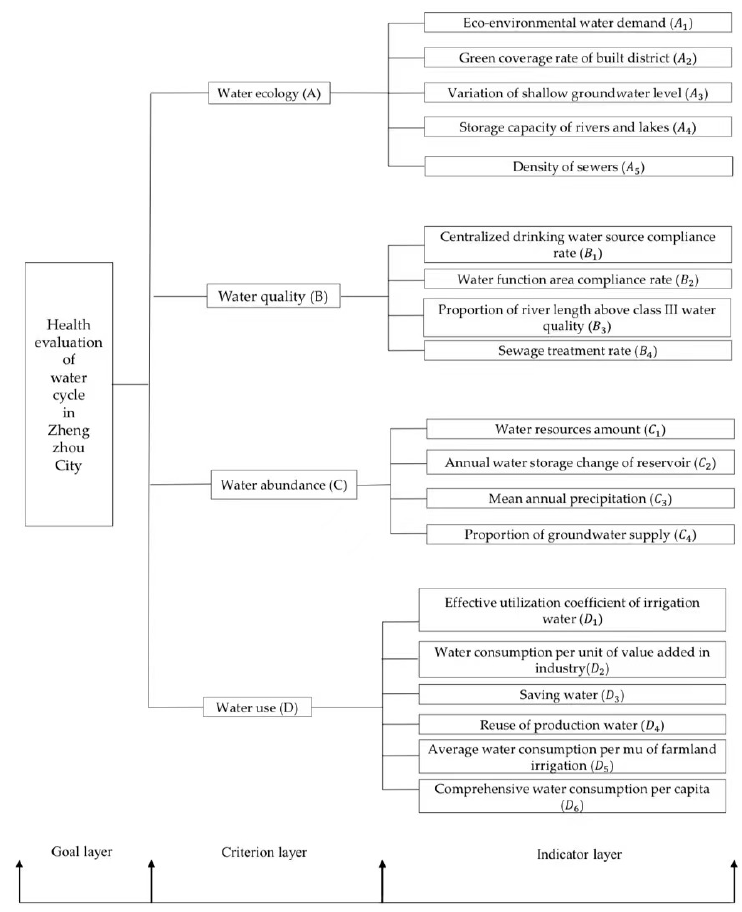
Figure 3. Schematic diagram of the indicator system.